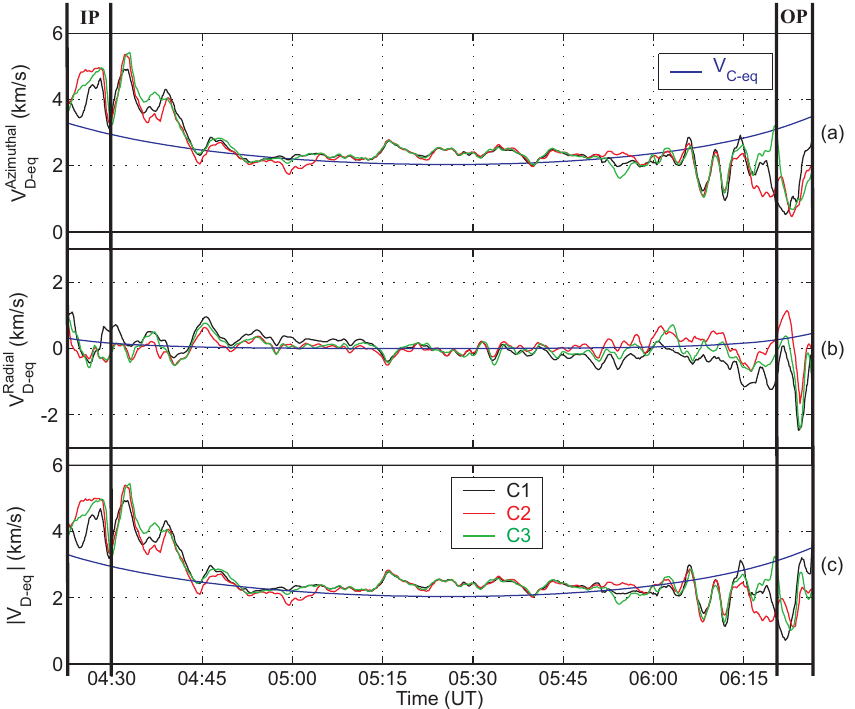
Fig. 16. Electron drift velocity V D − eq measured by EDI and projected onto the magnetic equatorial plane during the plasmasphere crossing of 11 April 2002 (similar as Fig. 5), with the inbound plume crossing (IP) and the outbound one (OP).